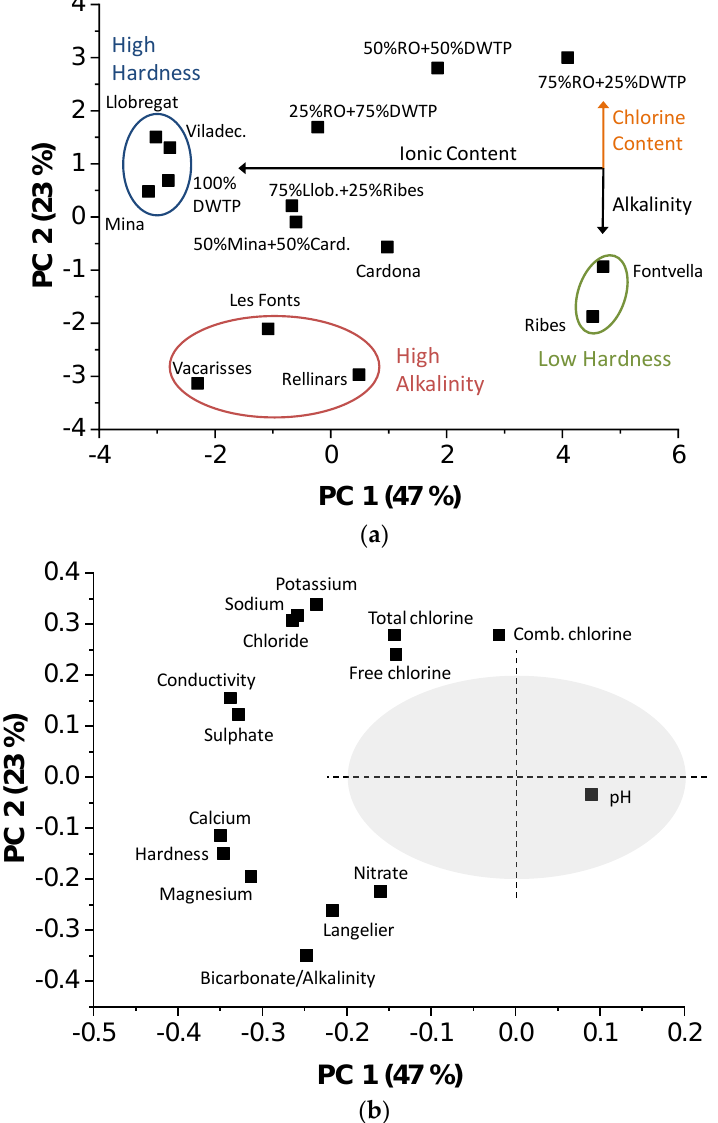
Figure 2. PCA ( a ) score plot and ( b ) loading plot obtained using the analytical data carried out by standard methods in the accredited laboratory. In the loading plot, the grey circle corresponds to the zone of low significance of the variables in the model. Llob.: Llobregat ; Card.: Cardona ;